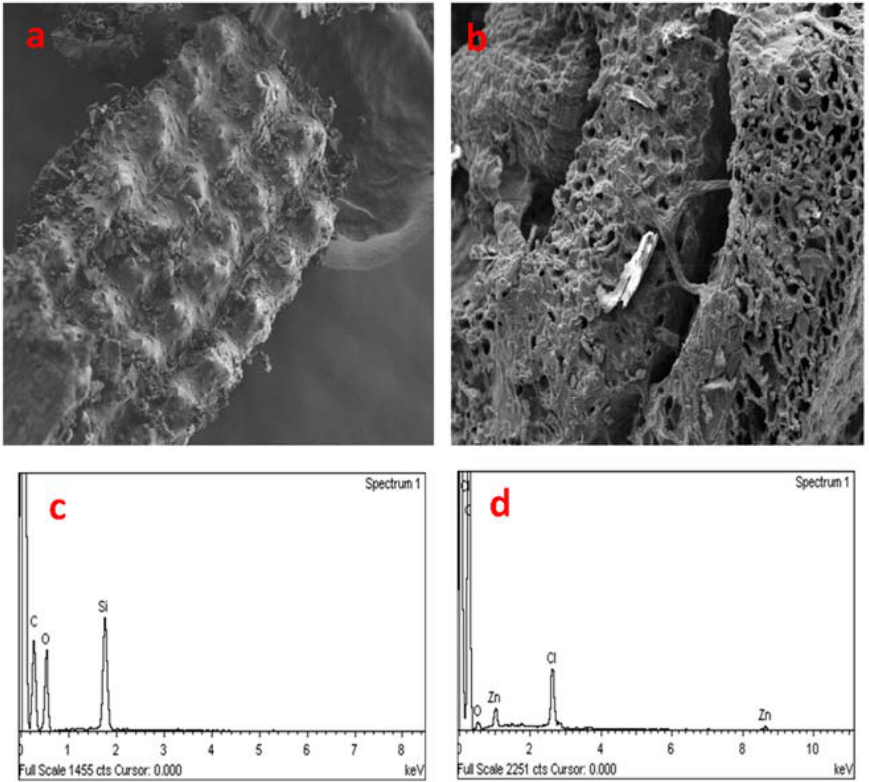
Figure 1. FESEM and EDX images of ( a , c ) rice husk (RH) and ( b , d ) rice husk activated carbon (RHAC) magnified 500 times.